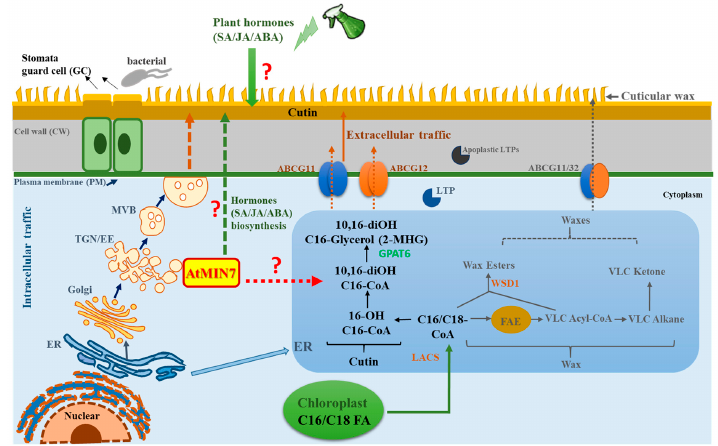
Figure 8. Hypothetical model representing the role of AtMIN7 involved in the cuticle formation and cuticle-associated defense response. The fatty acyl groups (C16/C18 FAs) are generated in the plastid, which are exported from the plastid to the ER as C16/C18-CoA. In the ER, C16/C18-CoA are synthesized as wax and cutin precursors [1,67] . The intracellular transport pathway for wax- and cutin-related components from the ER to the plasma membrane (PM) are predicted by several putative mechanisms, one of which is the Golgi or TGN-mediated secretory pathway [1,13–15] . Multivesicular bodies (MVBs) are the late endosomes in plants, which can form intraluminal vesicles involved in the delivery of defense cargoes upon the pathogen infection [75,76] . Here, MVBs might be involved in the intracellular transport of the wax- and cutin-related components. The extracellular export of the wax- and cutin-related components across the PM and cell wall of Arabidopsis is predicted to be carried out by the ATP-binding cassette (ABC) transporters and lipid transfer proteins (LTPs) [13,17,52]. However, very limited knowledge was known for the detailed mechanisms. TGN / EE serves as a key sorting station at the intersection of secretory and endocytic pathways [27]. ARF-GEF proteins play a critical role in vesicle budding and vesicular protein sorting [39,40]. In the present study, the TGN / EE-localized AtMIN7, an Arabidopsis ARF-GEF, is discovered to be critical for the cutin formation, which may play important roles in the sorting, assembling, or delivering cutin precursors or other related important components, such as the proteins and enzymes, involved in cutin formation through the intracellular tra ffi cking